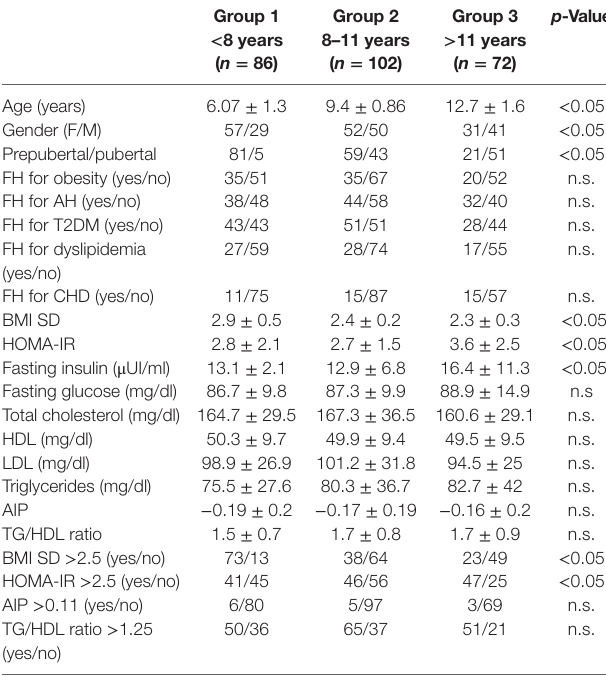
Table 4 | Comparison among three groups according to age of patients. Table 3 | Stepwise multivariate logistic regression analysis for BMI SD, HOMA-